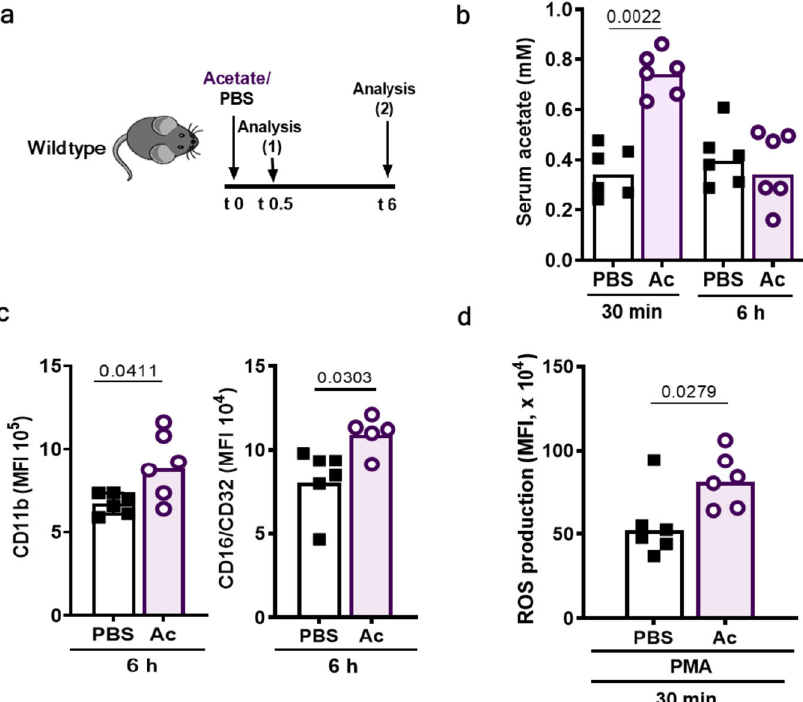
Fig. 3 Intraperitoneal acetate injection increases serum acetate levels and primes neutrophils in mice. a Mice received an intra-peritoneal acetate (Ac) injection (500 mg/kg) followed by analysis of blood acetate concentrations (isolated from the tail vein) and neutrophil phenotypes 30 min and 6 h after injection. b Acetate (Ac) i.p. injection caused a two-fold serum acetate increase 30 min after injection and normal serum acetate levels were restored after 6 h. c Neutrophils isolated from mice treated with acetate showed enhanced complement (CD11b) and Fc γ (CD16/CD32) receptor expression compared to PBS-treated mice. d In vivo acetate (Ac) injection caused increased ROS production upon stimulation with phorbol-12-myristat-13-acetate (PMA). Data in all panels represent geometric means from six animals. * P < 0.05; **P < 0.01 signi fi cant difference versus the indicated condition as calculated by Mann – Whitney U test.